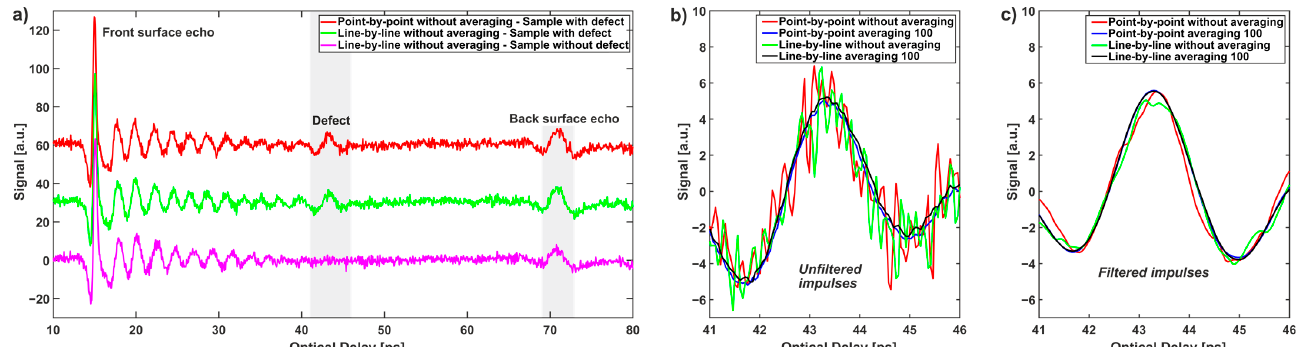
Figure 11. Waveforms reflected from the center of the defect with the diameter of 19 mm ( a ). Unfiltered ( b ) and filtered ( c ) impulses corresponding to the defect.